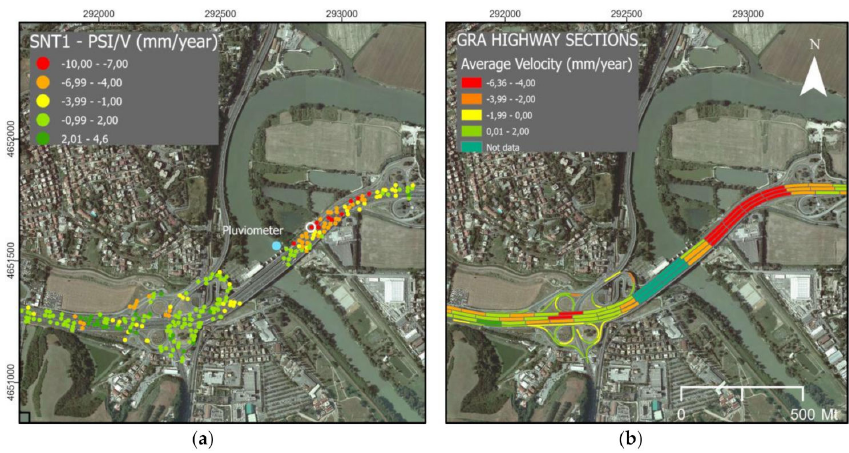
Figure 7. ( a ) Displacement map PSI Sentinel-1 for GRA highway ( b ) GRA sections, as background orthophoto Rome.